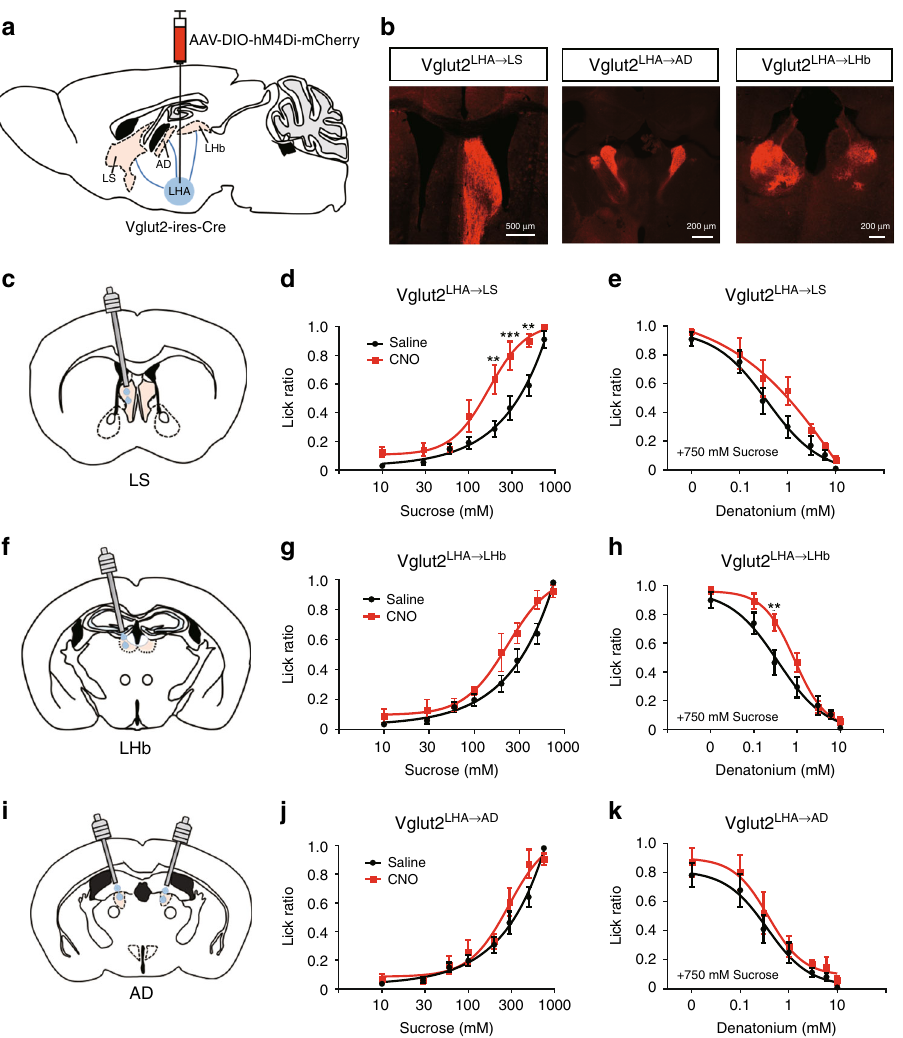
Fig. 6 Two distinct hypothalamic pathways contribute to the modulation of sweet and bitter preferences. a Injection of AAV-DIO-hM4Di-mCherry into the LHA of Vglut2-ires-Cre mice. b Representative image of the projection regions (LS, AD, and LHb) of Vglut2 LHA neurons. c – k Brief access taste tests after local inhibition of Vglut2 LHA neurons projecting to the LS ( c ), LHb ( f ), or AD ( i ) by microinfusion of CNO, respectively. Preferences toward sweet taste ( d , g , j ) or bitter taste ( e , h , k ) were evaluated 10 min after microinjection of CNO (0.1 mg/ml, 200 nl). n = 6, F = 34.32, and P = 8.9 × 10 – 8 in d , n = 6, F = 4.768, and P = 0.0326 in e , n = 6, F = 7.727, and P = 0.0071 in g , n = 6, F = 13.44, and P = 0.0005 in h , n = 5, F = 3.564, and P = 0.063 in j , and n = 5, F = 2.823, and P = 0.098 in k , two-way ANOVA with Bonferroni post hoc test. All experiments were carried out with 10- to 16-week-old male mice. Data are given as means ± SEM. * P < 0.05, ** P < 0.01, *** P <